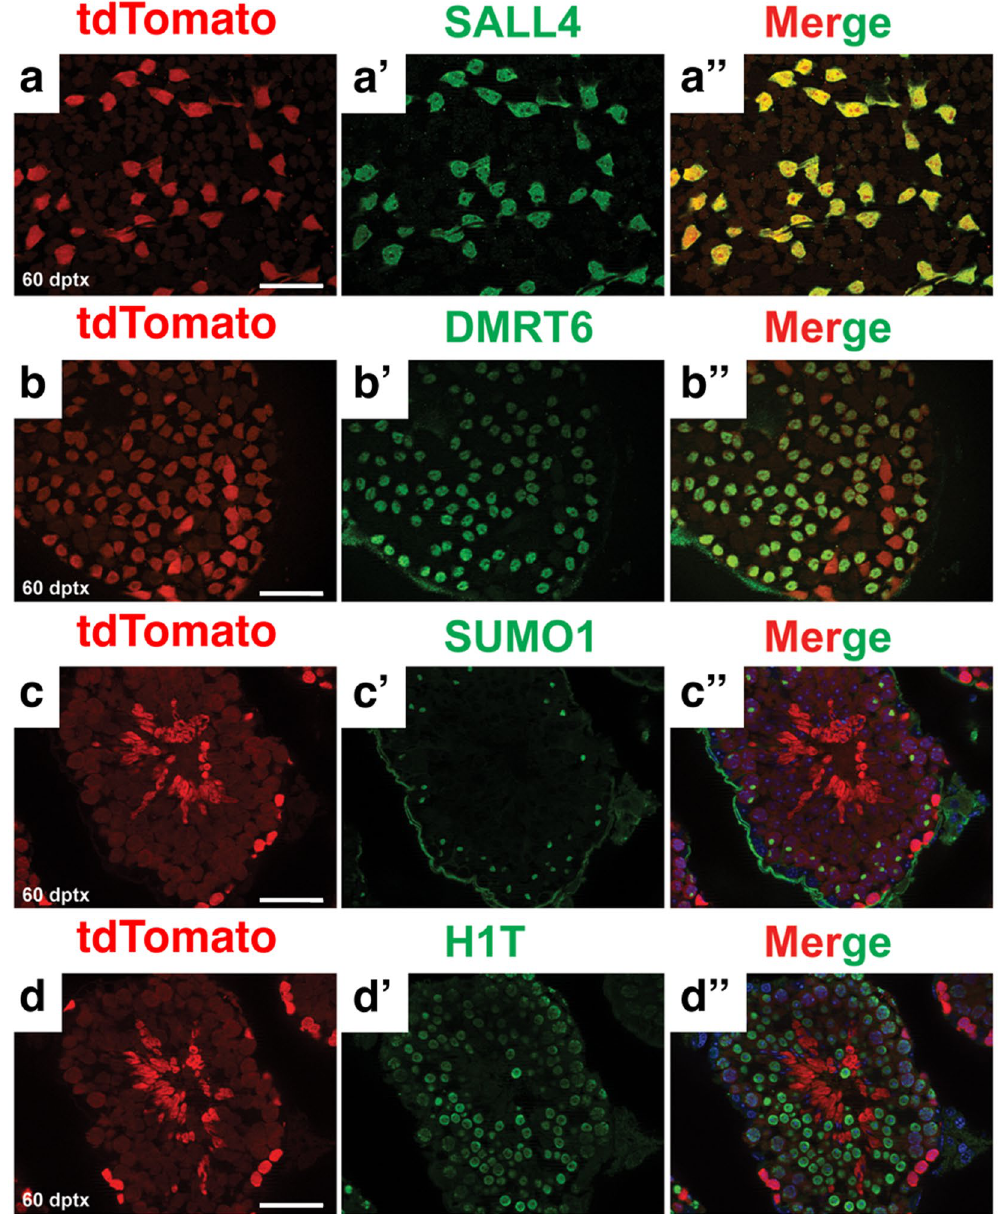
Figure 8. Sall4 GCE is active in SSCs. Immunofluorescence of wholemount ( a –b”) and cross sections ( c –d”) of seminiferous tubules. Sall4 GCE; R26-tdTomato testis 60 days post-tamoxifen treatment stained for tdTomato (red), SALL4 (green), DMRT6 (green), SUMO1 (green) and H1T (green). Scale bars in panel a,b,c,d: 100 µ m. All panels are in the same